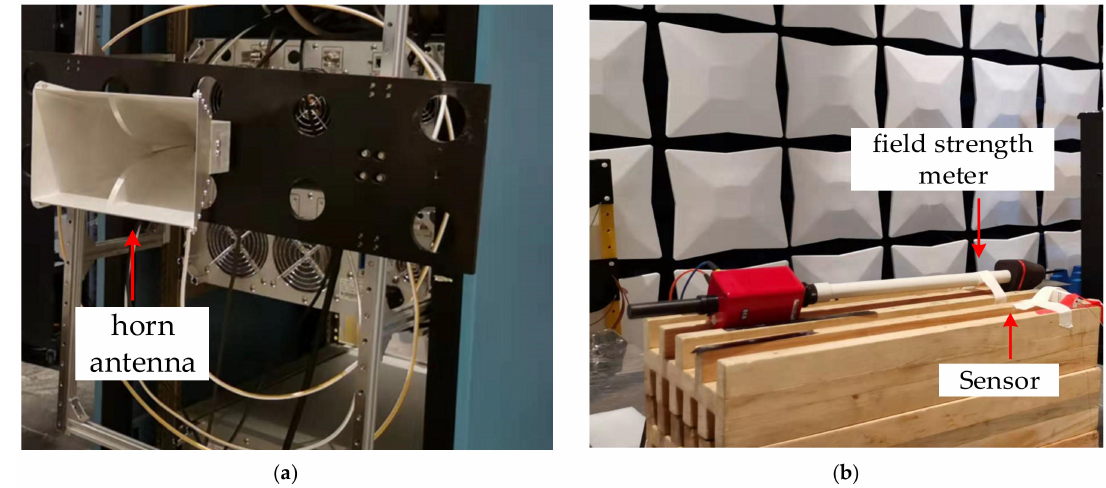
Figure 9. Photograph of sensor frequency response measurement setup: ( a ) radiation area; ( b ) receiving area.